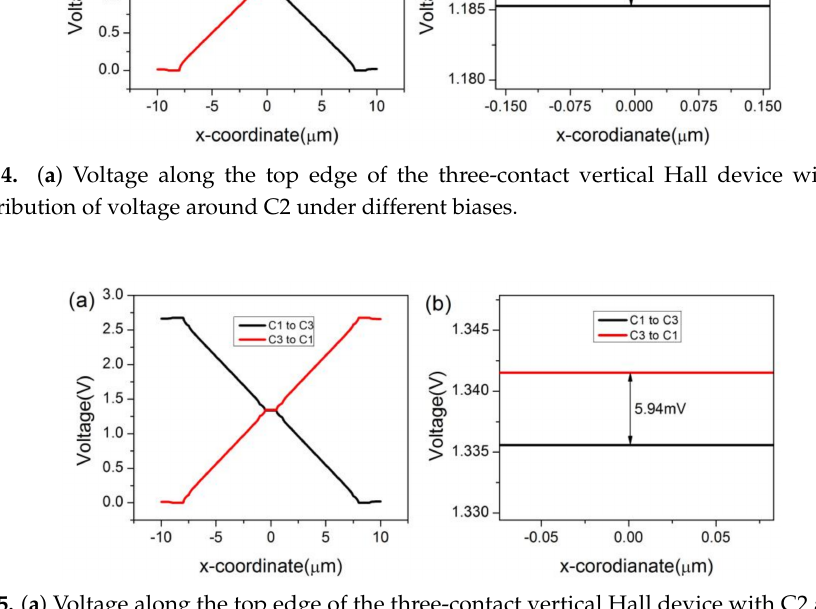
Figure 5. ( a ) Voltage along the top edge of the three-contact vertical Hall device with C2 and P-type layers and ( b ) distribution of voltage around C2 under different biases.